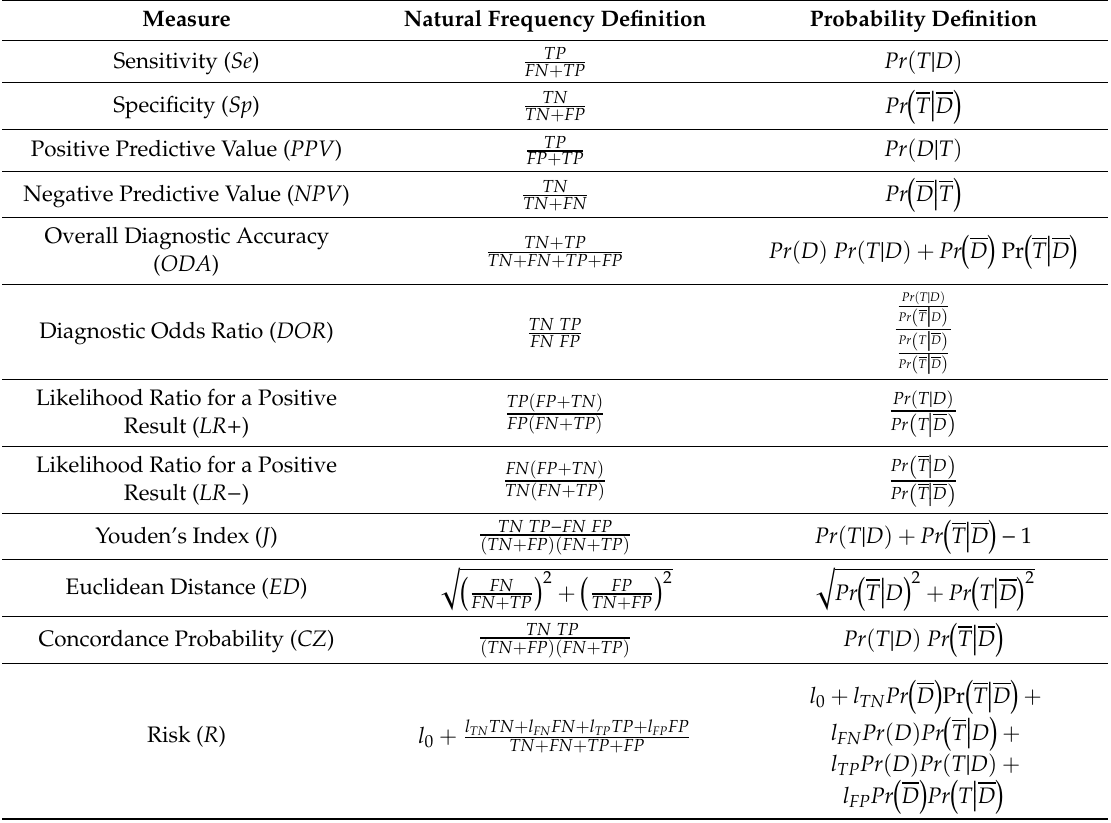
Table 2. Natural frequency and probability definitions of diagnostic accuracy